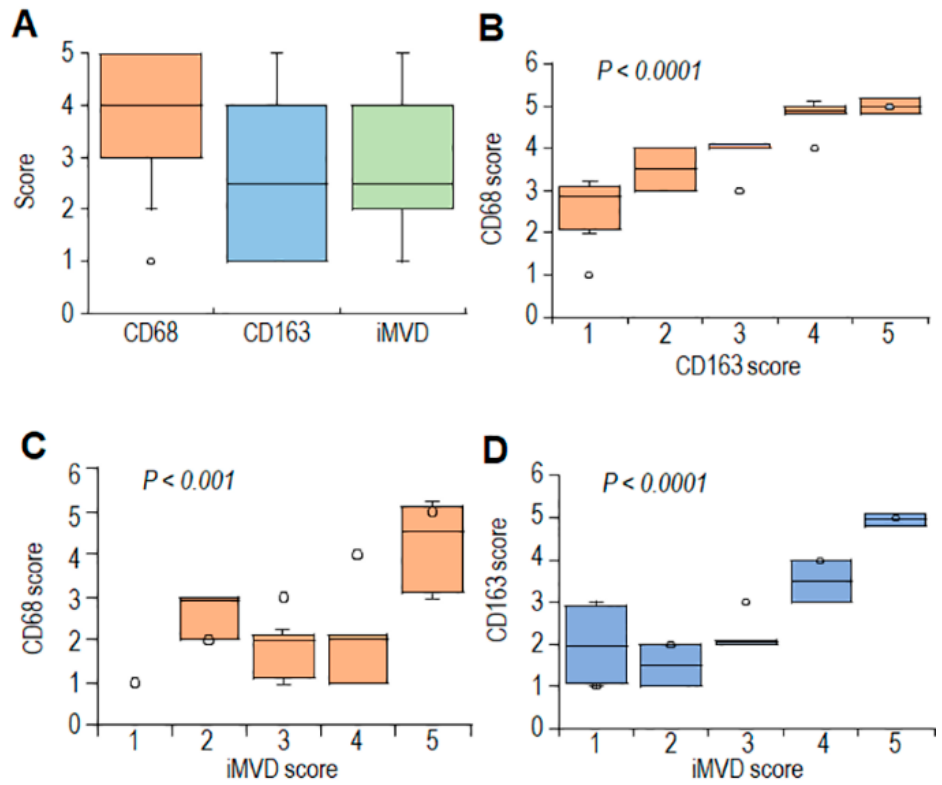
Figure 2. Relationships between CD68, CD163, and CD31 expression levels in tumor tissues from CHS patients. ( A ). Box plot, showing variation in the distribution of CD68, CD163 and intratumor microvessel density (iMVD) scores in CHS tissues. ( B , C ). Box plots showing CD68 scores in CHS tissues according to CD163 ( B ) and iMVD ( C ) scores. ( D ). Box plot, showing scores of CD163 scores in CHS tissues according to iMVD scores. Dark horizontal lines represent the medians. Circles represent outliers.